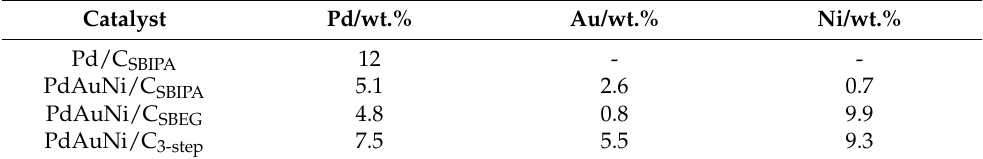
Table 2. ICP-OES metal composition of Pd/C SBIPA , PdAuNi/C SBIPA , PdAuNi/C SBEG , and PdAuNi/C 3-step .